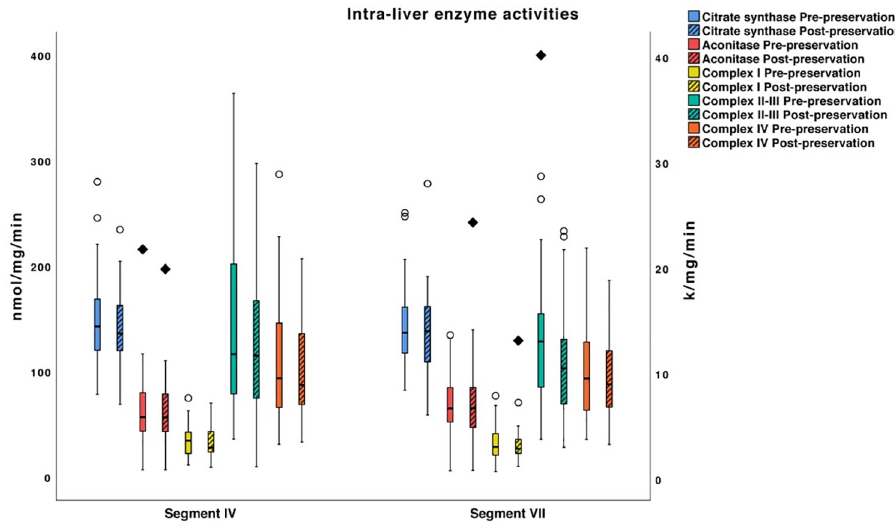
Fig 4. Box whisker plots of mitochondrial enzyme activities in liver segments IV and VII. The plots demonstrate the distribution of enzyme activities round the median in each segment, shown before and after 4-hr preservation. The enzyme activities were not significantly different between segments IV and VII (p > 0.05). The activities of citrate synthase, aconitase, complex I-III are expressed in nmol/mg/min while the activity of complex IV is expressed in k/ mg/min. Top and bottom whiskers represent the maximum and minimum values, respectively. Circles represent outliers (1.5 to 3x interquartile range) and diamonds represent extreme outliers ( > 3x interquartile